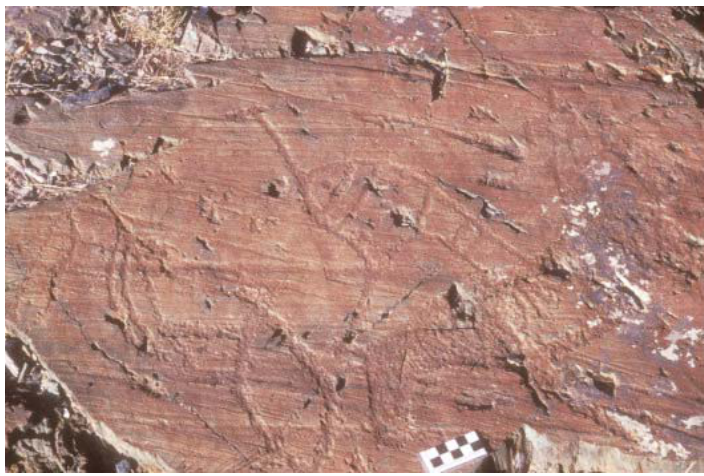
Figure 25. Two ostriches and a horse. Pre-Bronze Age. Aral Tolgoi. (http://oregondigital.org/u?/maic,2137).